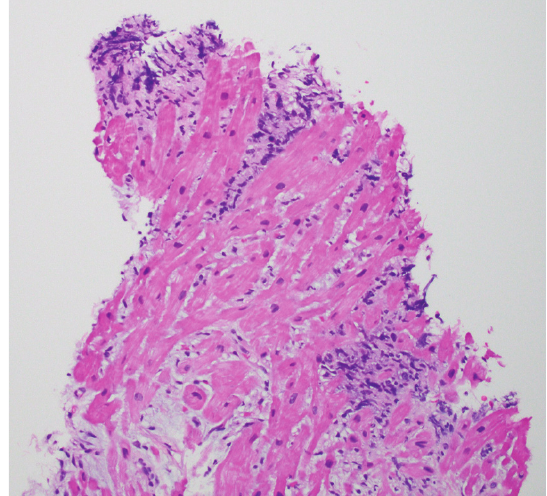
Figure 6: Pathology specimen of cardiac tissue demonstrating lymphocytes infiltrating the cardiac muscle, consistent with cardiac lymphoma.